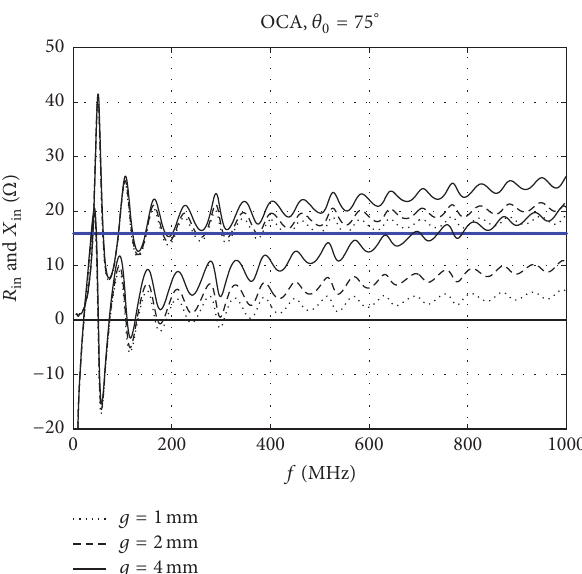
Figure 25: 𝑆 11 of the OCA for 3 different gap lengths, 𝜃 0 = 45 ∘ and Ω 𝑍 𝑟 = 50